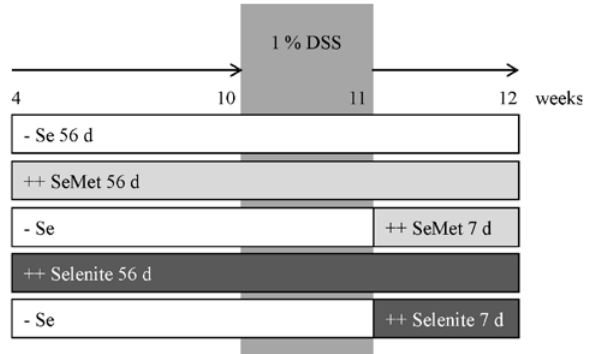
Figure 2. Study design. At the age of 4 weeks, mice were adjusted either to the suboptimal selenium diet (− Se) or to diets supplemented with selenomethionine (SeMet) or selenite (++ SeMet 56 days or ++ Selenite 56 day). At the age of 10 weeks, they received 1% DSS via the drinking water for one week. With DSS withdrawal, short-term supplementation of mice with a suboptimal selenium status started for another week (++ SeMet 7 days, ++ Selenite 7